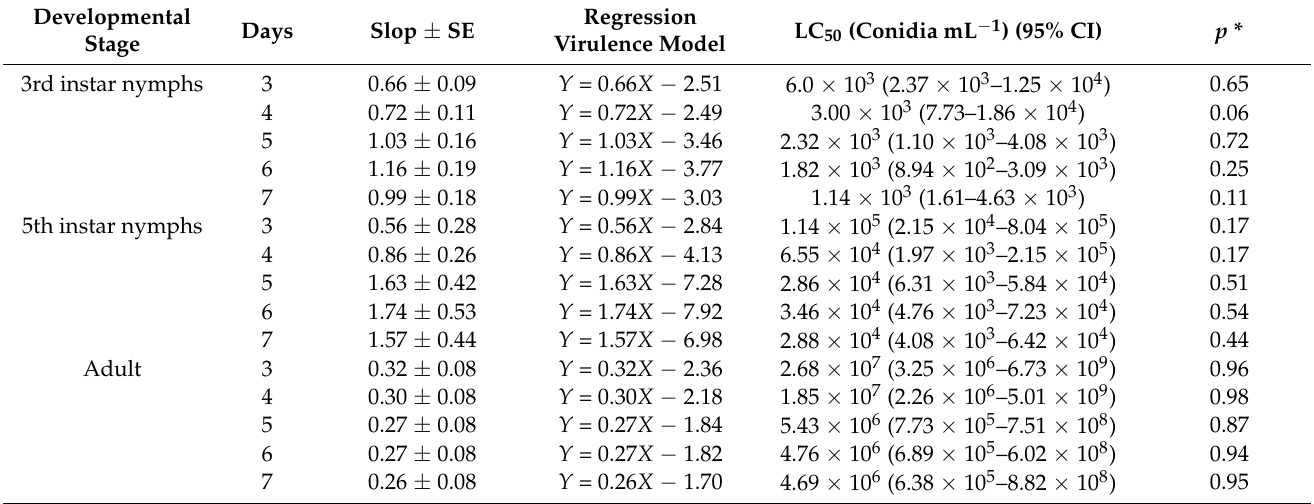
Table 2. Pathogenicity regression equations for LC 50 values of C. fumosorosea SCAU-CFDC01 against D. citri .